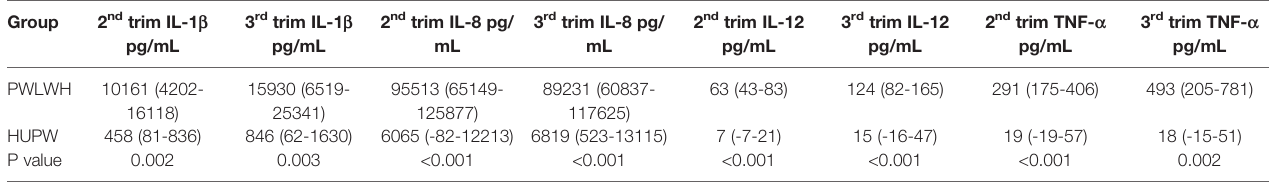
TABLE 3 | Mean IL-1 b , IL-8, IL-12 and TNF- a in second and third trimesters by HIV status. Group